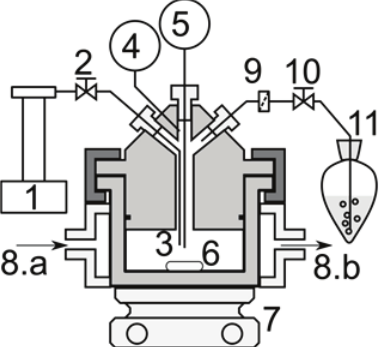
Fig. 2 – Schematic representation of the high pressure auto- clave (not proportional): 1. ISCO 260D syringe pump; 2. inlet valve; 3. CO inlet pipe; 4. pressure transducer; 5. thermocou- 2 ple; 6. stir bar; 7. magnetic stirrer; 8a and b. tempered